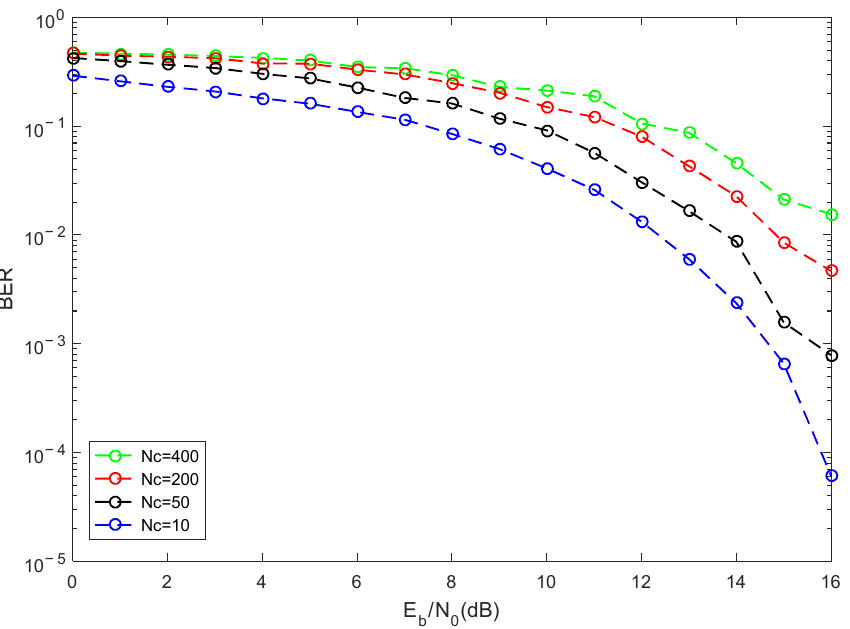
11 of 14 Figure 7. BER performance of the proposed MC-MDCSK-MCS with different fractional orders over the AWGN channel.